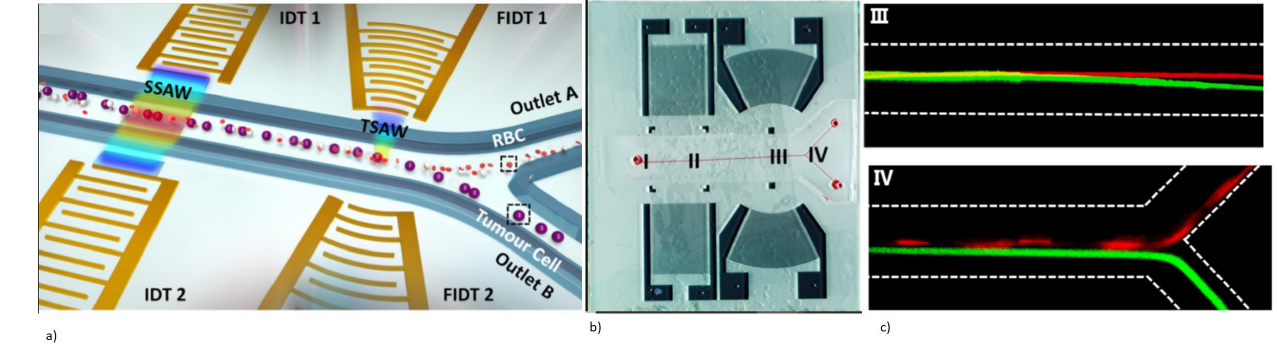
Figure 39. ( a ) SAW-based multistage microfluidic device for CTC separation from RBC. ( b ) Fabricated device with IDT and FIDT. ( c ) CTC separation trajectory in the positions marked III and IV in ( b ). The unidirectional TSAW generated by FIDT in III, pushes the CTC away from RBC and isolates them to outlets A and B in the section marked IV [328]. Reproduced with permission from Kaiyue Wang et al., Sensors and Actuators B: Chemical; published by Elsevier,